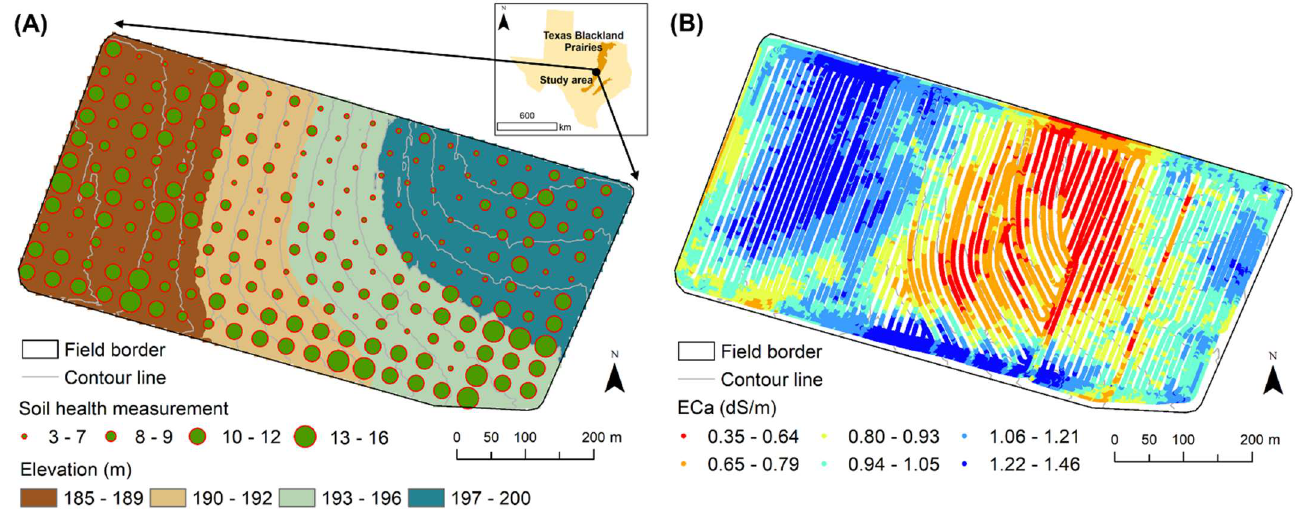
Figure 1. ( A ) Soil sample locations with soil health measurements overlaid on elevation map, and ( B ) apparent electrical conductivity (ECa) measurements in the study area. [Inset: Location of study site in the Blackland Prairies ecological region in Texas].